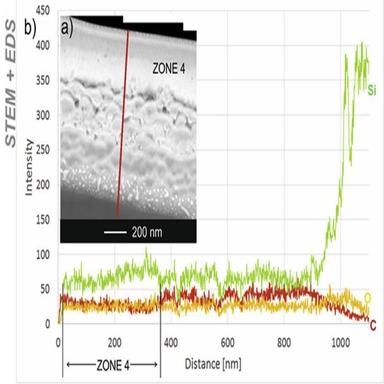
Qualitative chemical analysis of the modified coating performed by EDS; a). STEM image with the marked line for EDS analysis and b). diagram of the selected elemental distribution along the line.